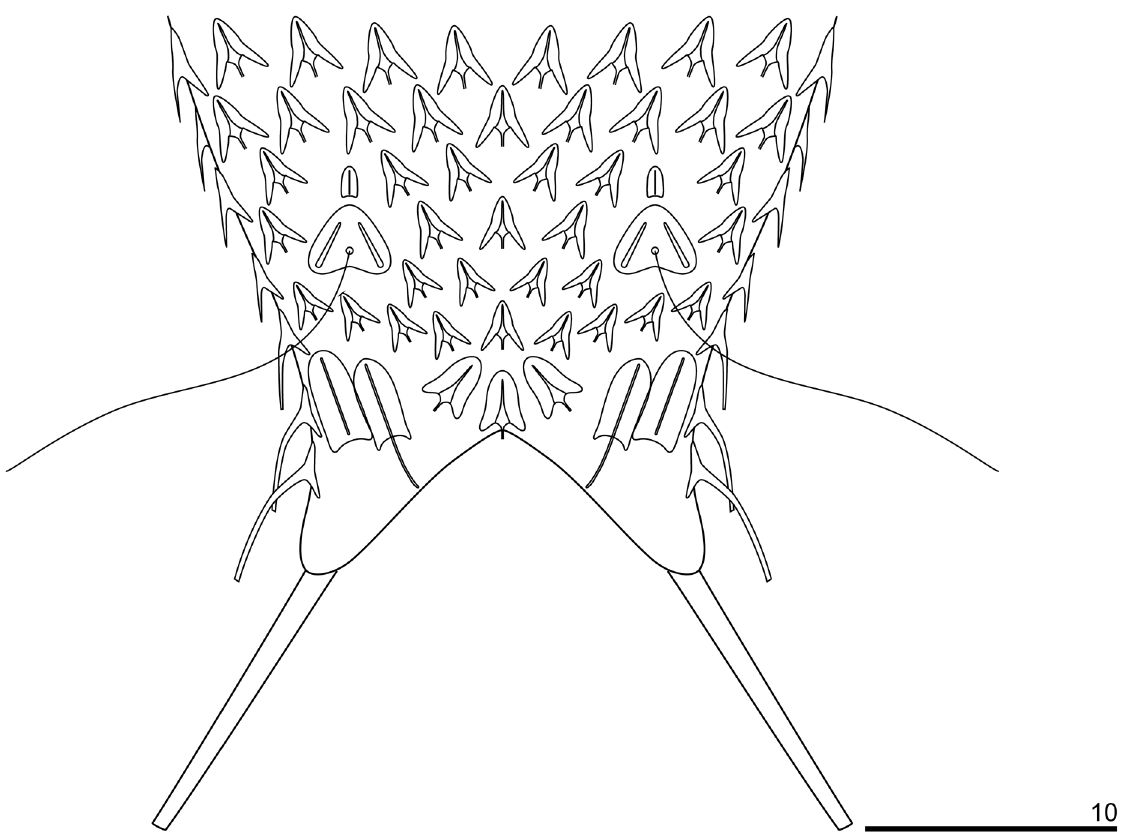
Fig. 6. Chaetonotus (Chaetonotus) antrumus Kolicka sp. nov., schematic drawings of the posterior trunk region, furcal base and furcal